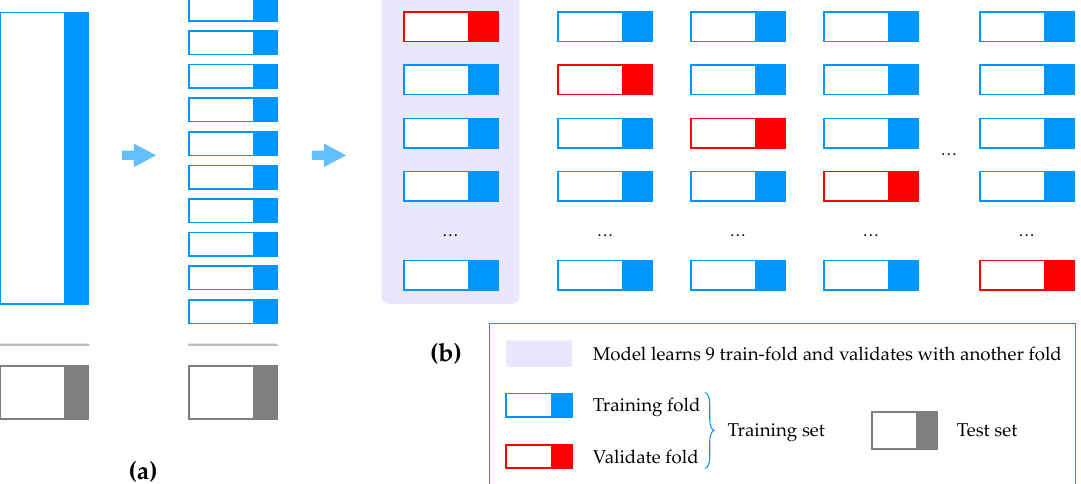
Figure 5. MLHC 10-fold cross validation: ( a ) dividing the training set into 10 folds; and ( b ) learning training-fold and validating with the other